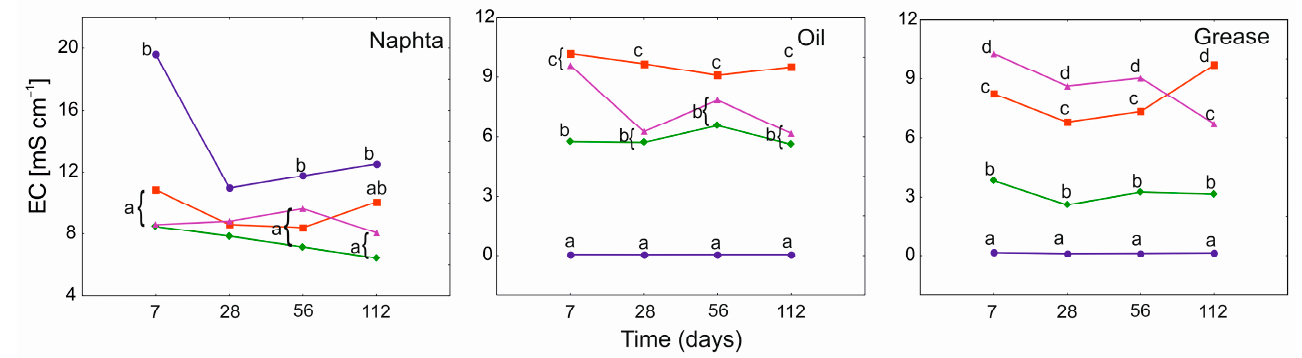
Figure 4. GLMM for mean electrical conductivity (EC) of heavy naphtha, lubrication oil, and grease for PGA treatment (blue and circle-PGA 0 , red and square-PGA 1 , green and diamond-PGA 1B , violet and triangle-PGA 10 ) and time (days). The different letters indicate the pairwise differences according to Duncan pairwise test. Mean values, standard error and confidence intervals are included in Supplementary Material Table S1.